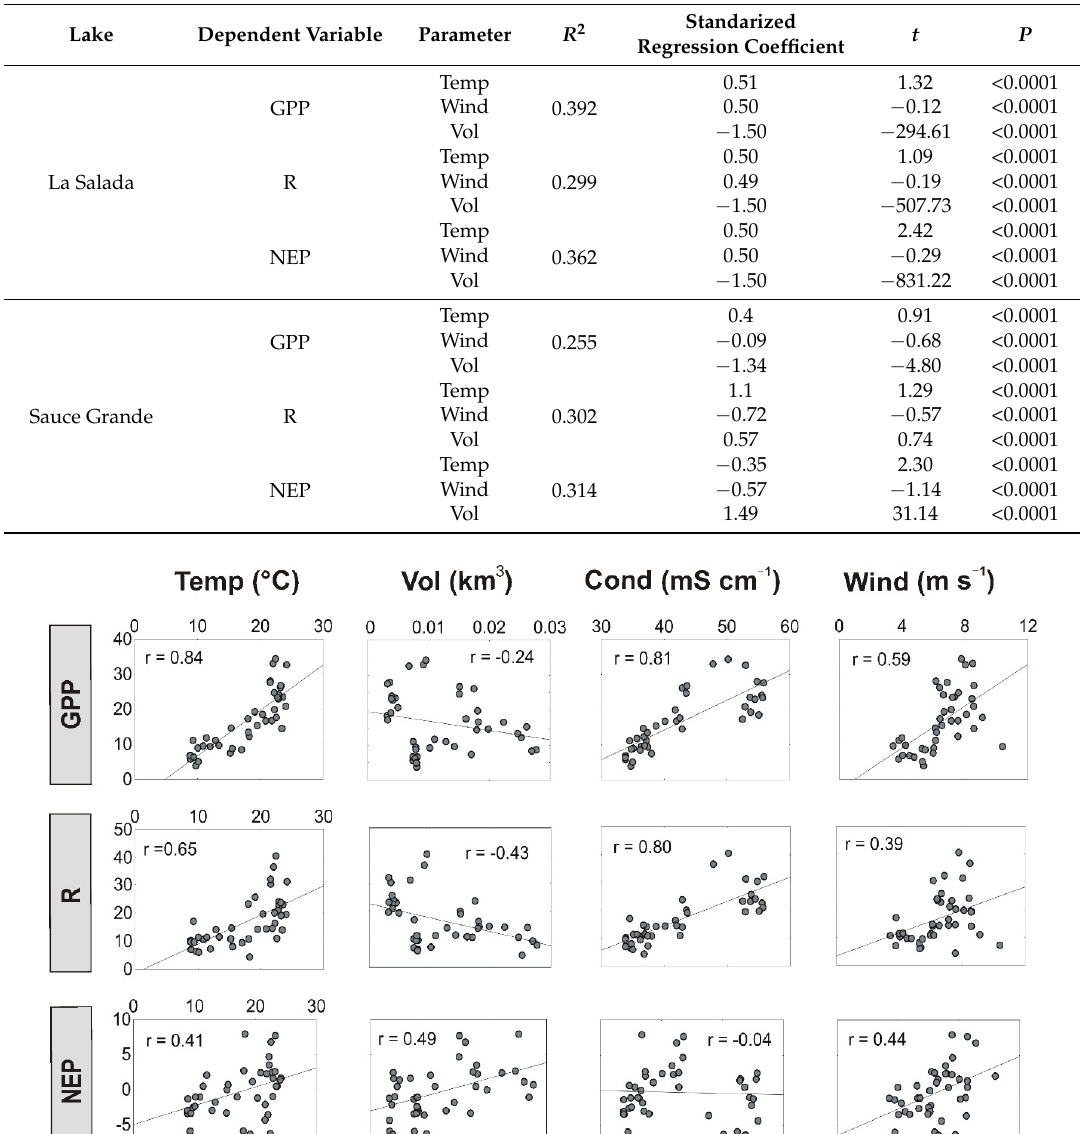
Table 3. Multiple regression analysis for GPP: Gross primary production, R: community respiration, and NEP: net ecosystem production as a function of Temp: water temperature ( ◦ C), Wind: wind speed (m s − 1 ) and Vol: lake volume (m 3 seg − 1 ) in the La Salada and Sauce Grande lakes during the study periods.